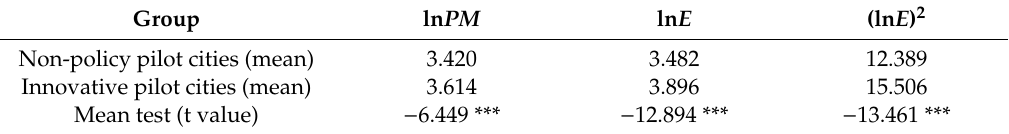
Table 4. Grouped inspection results of innovative cities and non-innovative